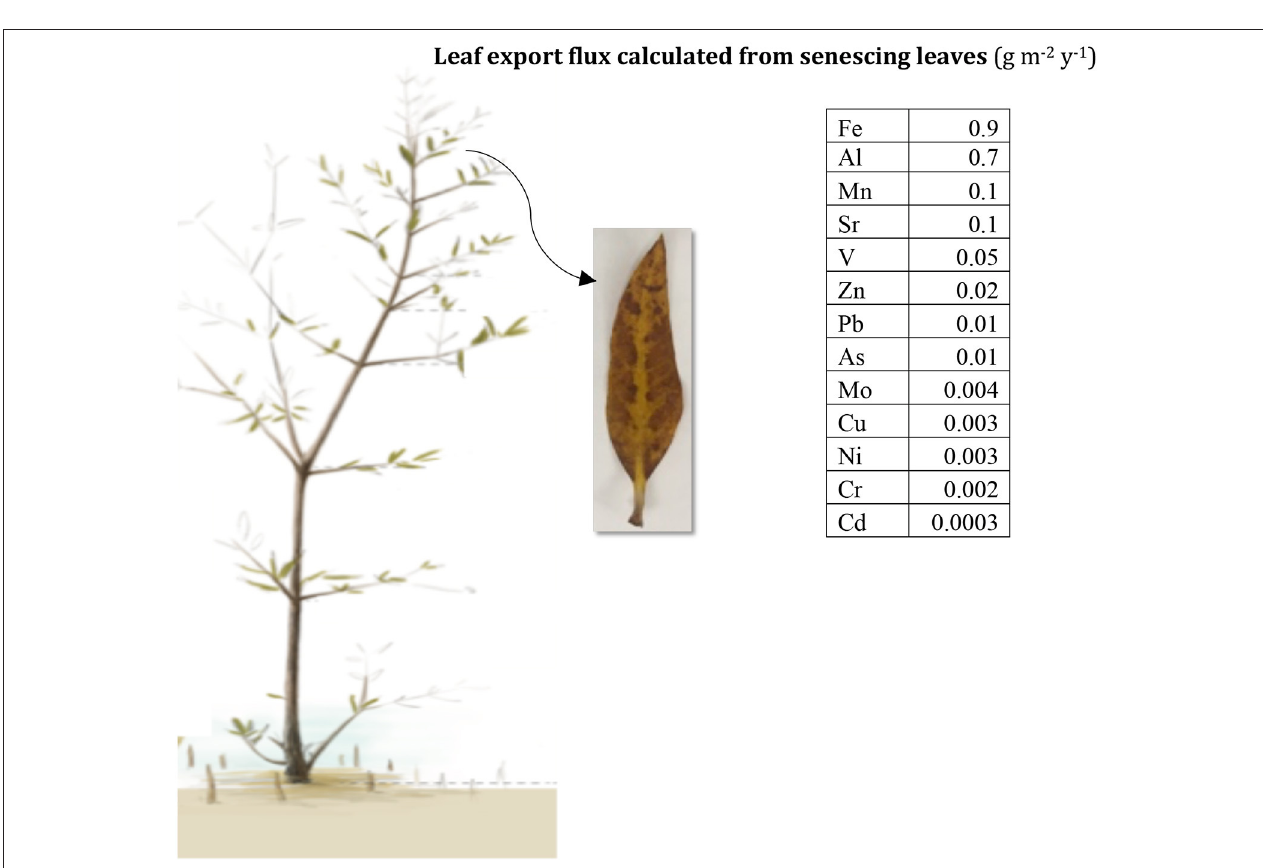
FIGURE 7 | Average flux of heavy metals input (g m − 2 y − 1 ) into surface soils from senescent leaves in Central Red Sea mangroves.